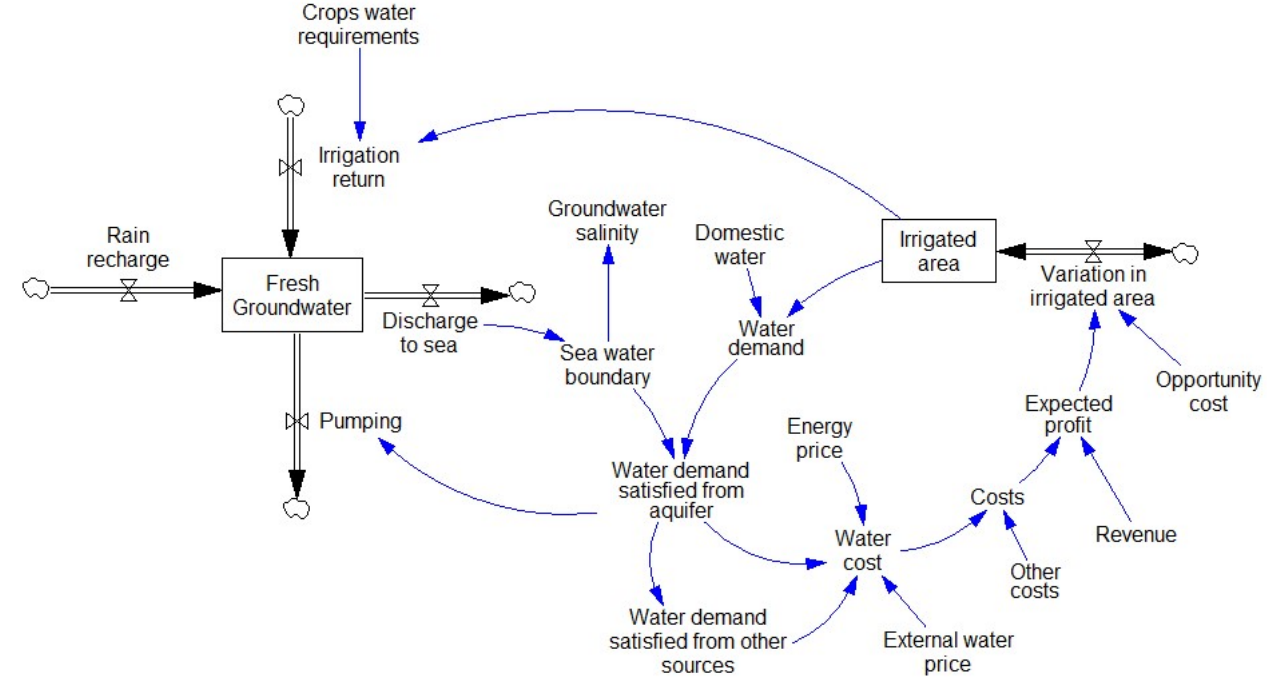
Figure 2. Stock and flow structure of the Aquacoast model adapted for the GSB case. Rectangles represent the stock variables of the model and double arrows and valves represent flow variables. The rest of elements in the sketch are auxiliary variables and parameters, whose influences are shown by blue solid arrows.